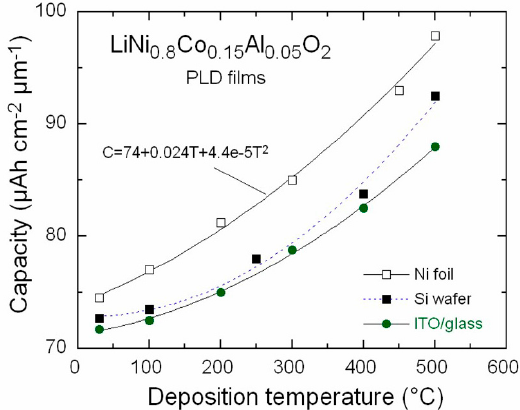
Figure 7. The specific capacity of LiNi 0.8 Co 0.15 Al 0.05 O 2 thin films deposited onto Ni foil, Si wafer, and ITO-coated glass as a function of the substrate temperature.